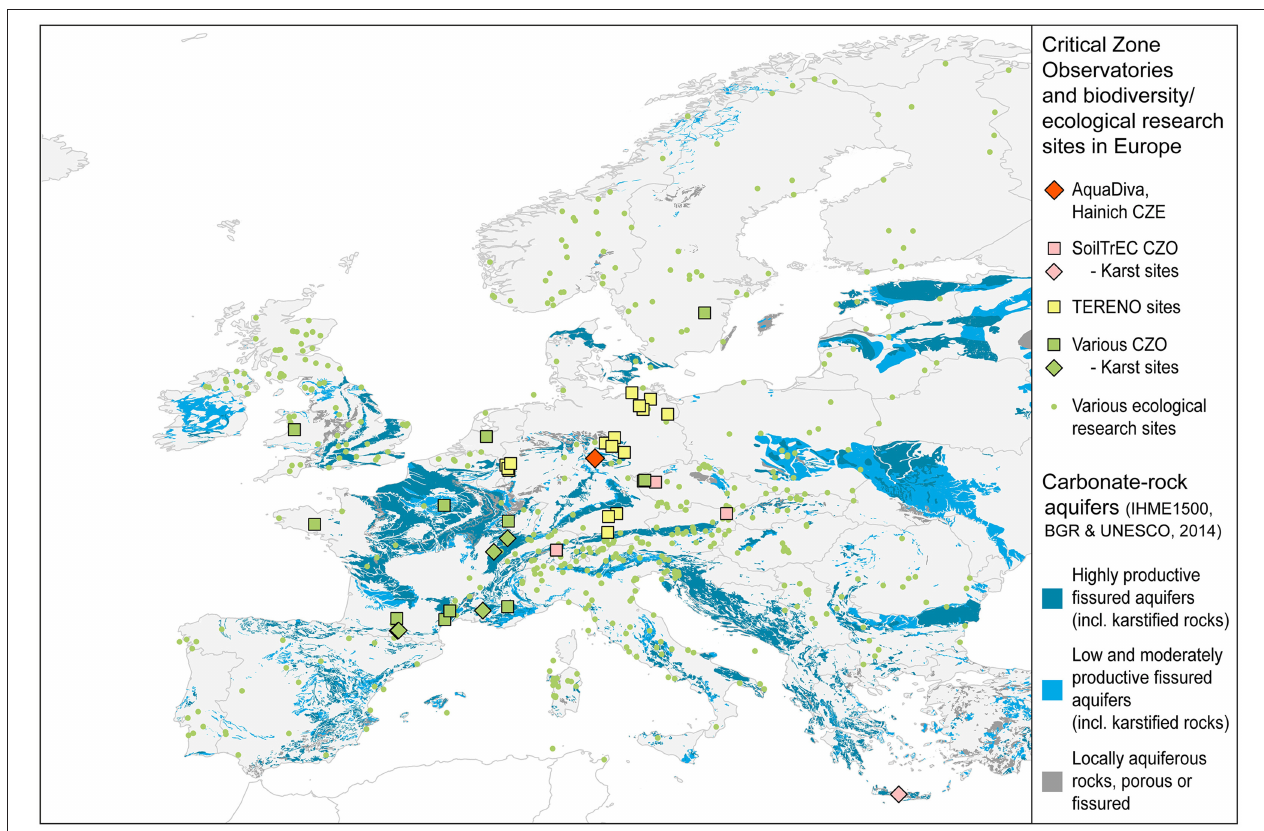
FIGURE 2 | Distribution and classification of carbonate-rock aquifers in Europe. European CZOs (squares) and biodiversity study sites (green dots) are mainly placed in non-carbonate geological settings or focus on the vegetation and shallow surface/soil biodiversity. Data Sources: BGR and UNESCO. (2014; aquifer distribution, aquifer classification), BGR (2005; base map). Research site locations: DEIMS (2015) 2 , RBV (2015) 3 , SoilTrEC (2015) 4 , TERENO (2015) 5